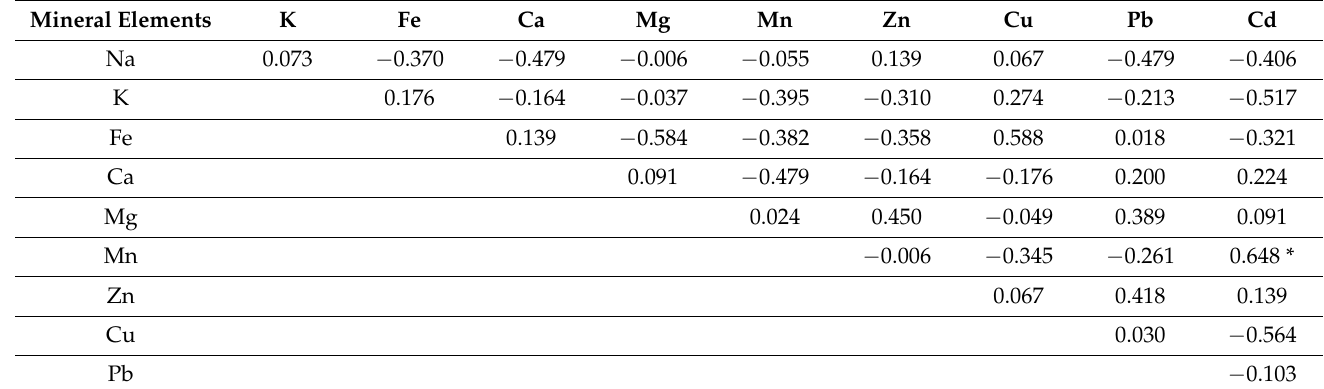
Table 9. Correlation coefficients (r xy ) for the levels of selected mineral elements and toxic metals in the muscle of red